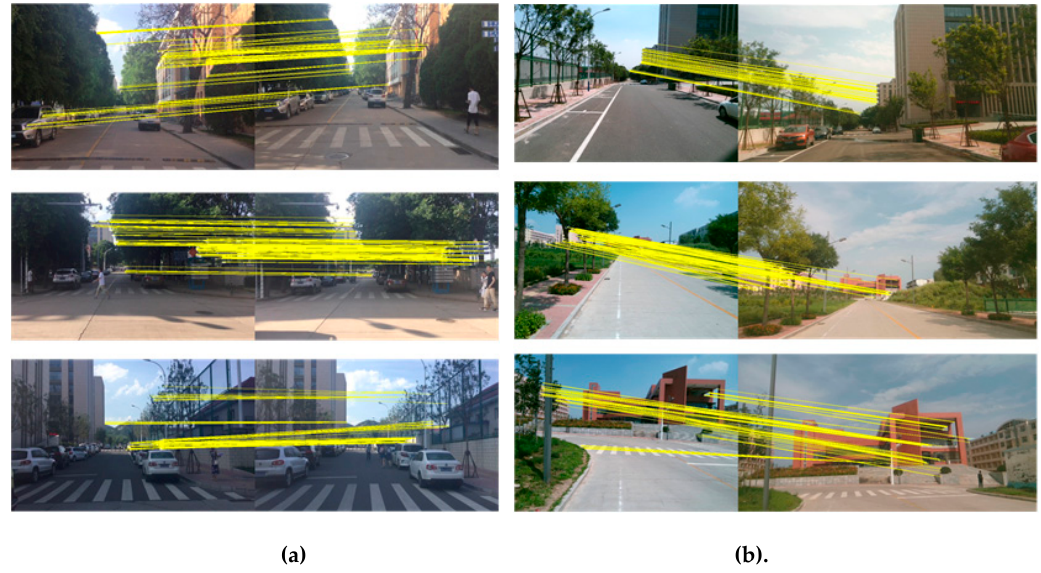
Figure 15. The result of the successfully matched feature points between real-time acquired images and template images by using the SI-GMS algorithm. ( a ) Experiment 1; ( b ) Experiment 2.